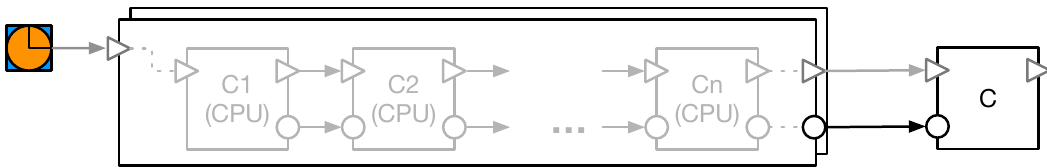
Figure 7. A system composed of chained